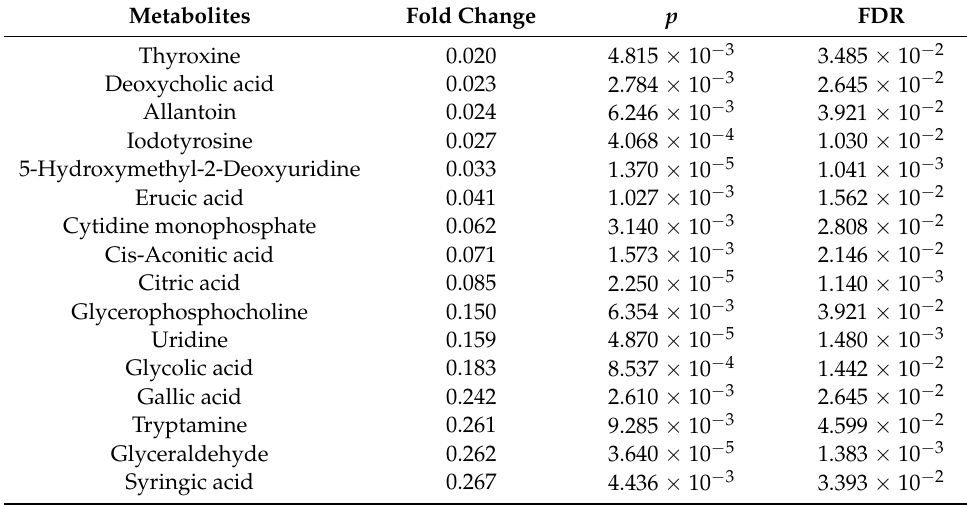
Table 1. List of the altered metabolites identified in the comparison between TN1 and